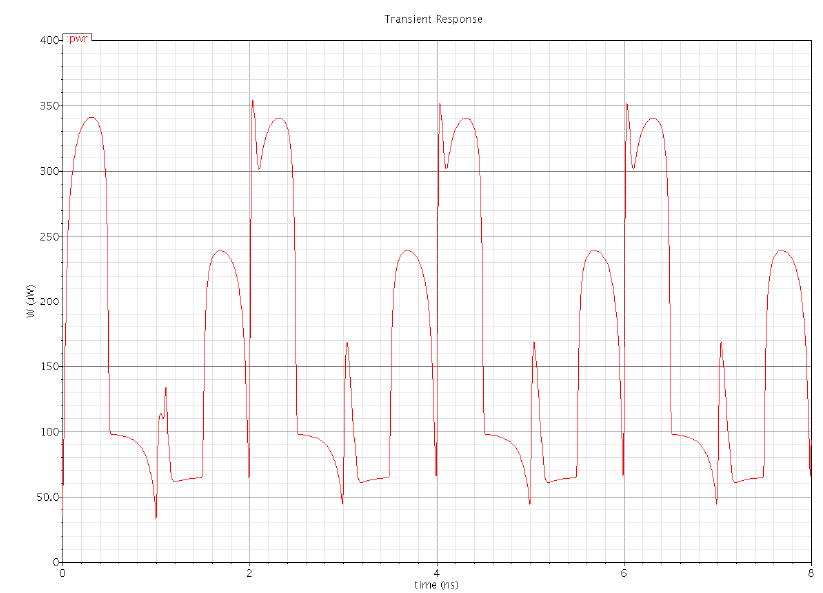
Figure 16. Total power dissipation in the modified C²MOS latch.